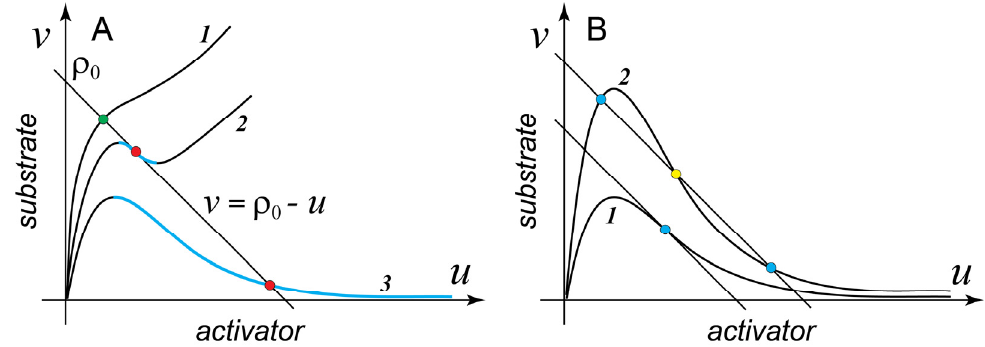
Figure 1. Properties of the reaction function F ( u , v ) on the phase plane ( u , v ) . ( A ) Shape of the reaction function determines the behavior of the model (see text). Intersections of the reaction function with the mass conservation line v = ρ 0 − u define phase space locations of the model’s spatially homogeneous steady states. Green circle, SHSS (spatially homogeneous steady state) stable to the Turing instability. Red circles mark SHSS that lie on the descending fragment of the reaction function (cyan) and are unstable to the Turing instability. ( B ) Any MCAS (mass-conserved activator-substrate) model (1) whose reaction function has a descending fragment has a domain of parameters in which it is monostable in the well-mixed regime (case 1) and also a domain of parameters in which it is bistable (case 2). Stable states are shown by blue circles, unstable is shown by yellow circle.